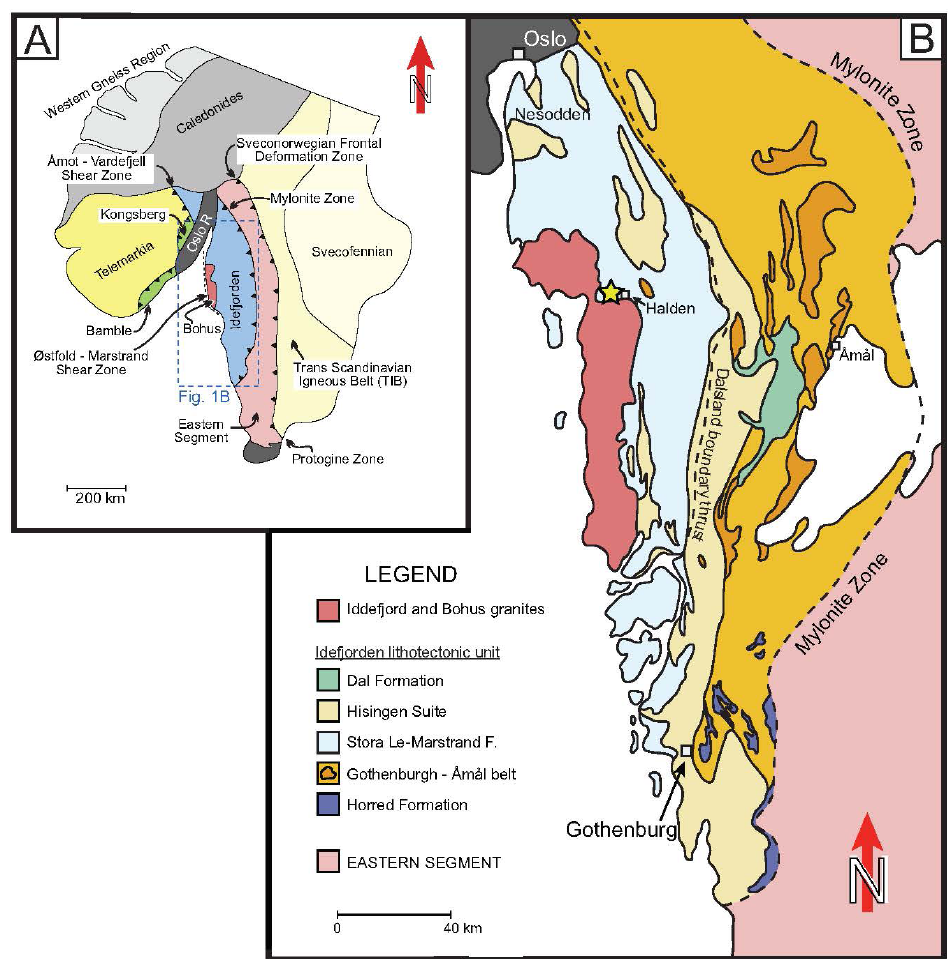
Figure 1. (A) Principal lithotectonic units of the Sveconorwegian Orogen and geographically related units, The figure is modified from Berthelsen (1980) and Bingen et al. (2005). (B) Geological map of the Idefjorden lithotectonic